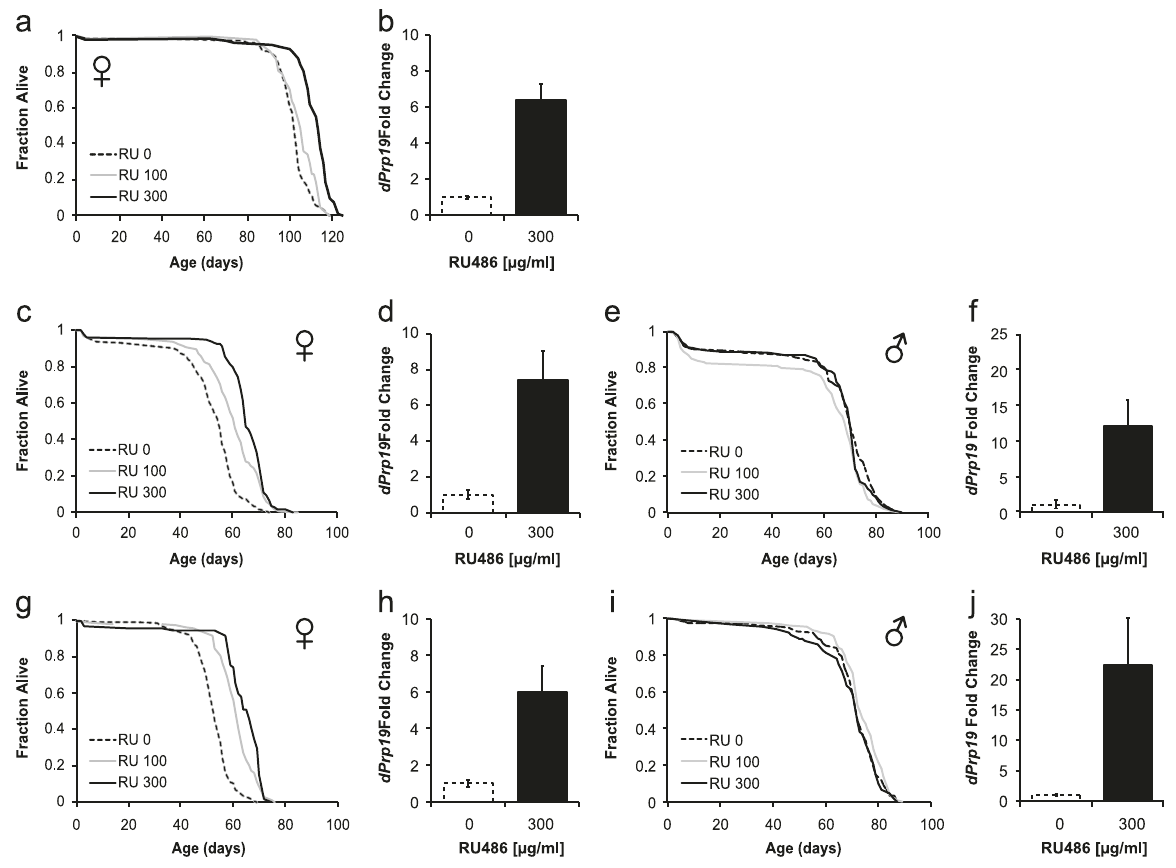
Fig. 2 Overexpression of dPrp19 leads to dose-dependent extension of female but not male life span. Effects of the induction of the dPrp19 UAS cassette in three independent chromosomal insertions of the same transgenic construct on adult survival and dPrp19 mRNA levels: a , b Tub GS-Gal4 > UAS- dPrp19-1 (females only), c – f da GS-Gal4 > UAS- dPrp19-2 (females and males), and g – j da GS-Gal4 > UAS- dPrp19-4 (females and males). a , c , e , g, and i show survival curves of experimental fl ies at three concentrations of the inducer drug RU486; b , d , f , h, and j show quanti fi cation of dPrp19 expression levels relative to the Rp49 control after 72 h of exposure to 300 µg/ml RU486. For all three overexpression constructs, we fi nd a signi fi cant dose-dependent extension of female life span. Overall, we did not fi nd any life span extension in males (for da GS-Gal4 > UAS- dPrp19 -2 males at 100 µg/ml RU486 we observed a slight reduction in survival, possibly due to inadvertent ‘‘ setup mortality ” that might have occurred when the assay was set up). For details of life span statistics see Supplementary Table 1 (females)